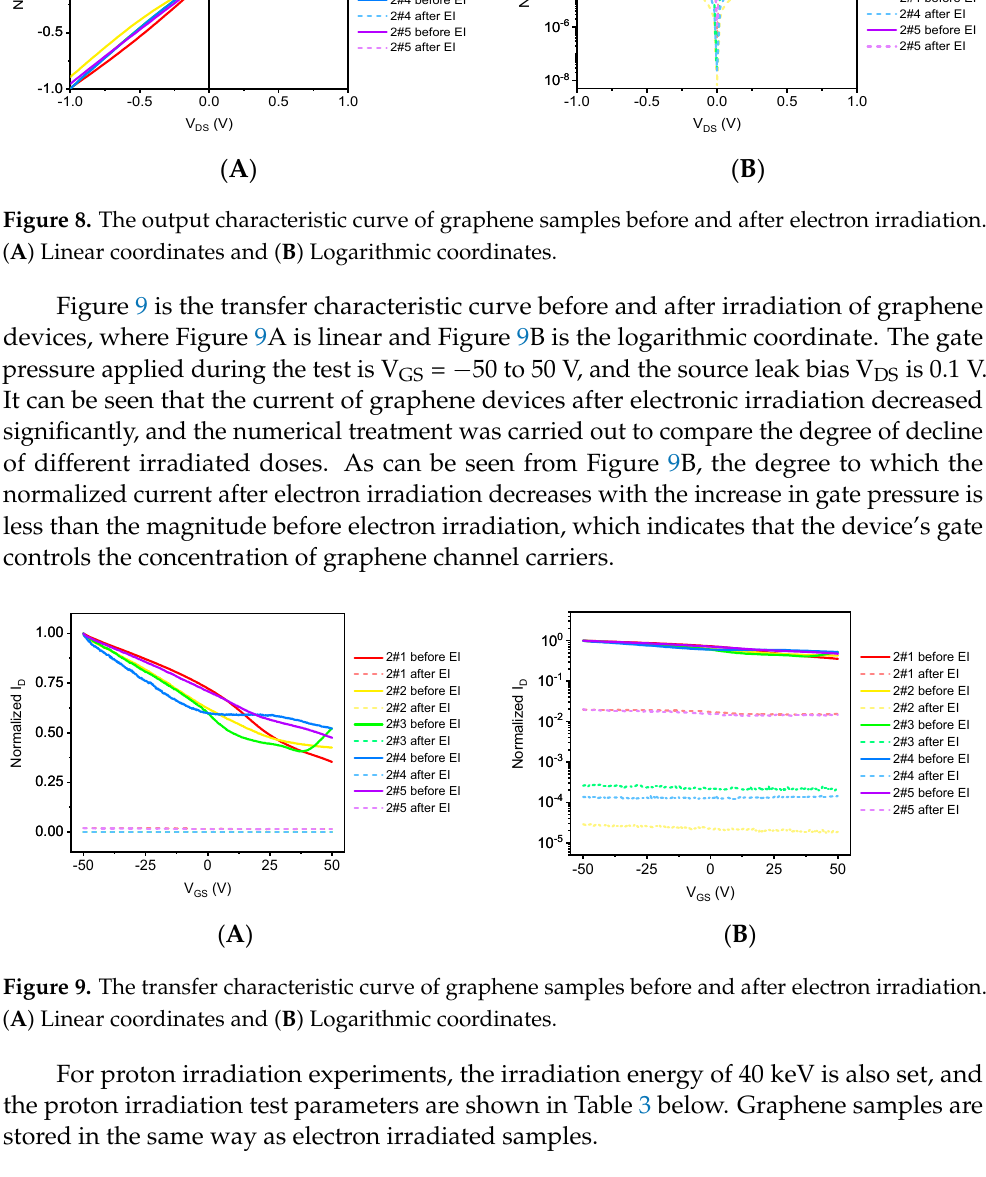
Table 3. Proton irradiation experimental parameters and sample classification.